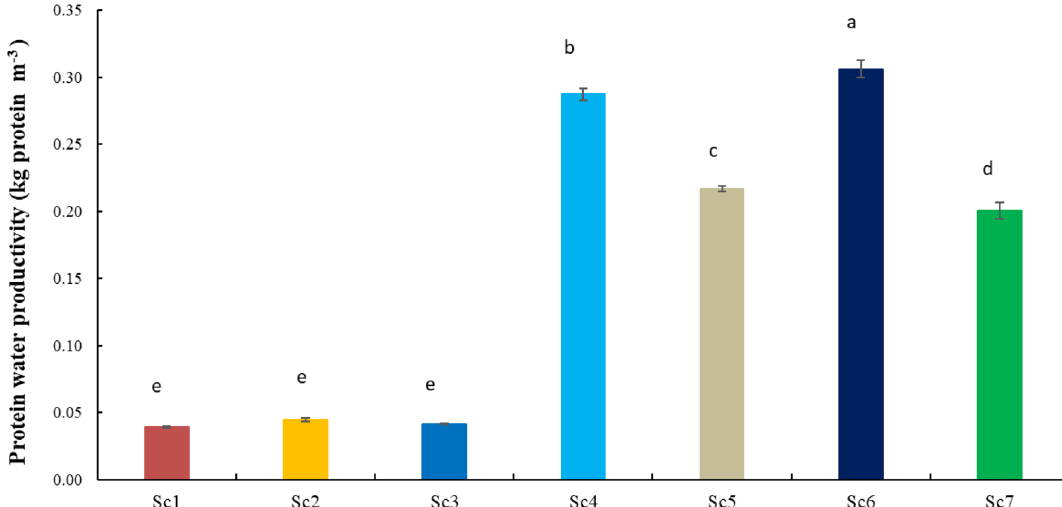
Figure 4. Protein water productivity (kg protein m −3 ) as affected by different cropping systems under various management scenarios (2 years